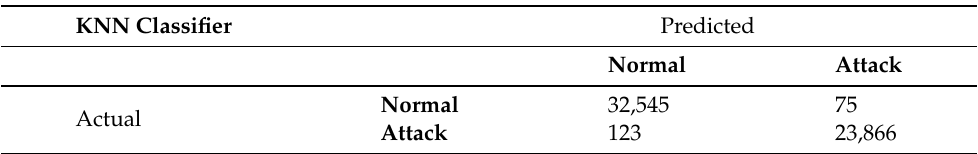
Table 4. Confusion matrix of K-Nearest Neighbors (KNN) classifier test for malicious and normal traffic detection over IoT healthcare dataset generated using IoT-Flock [16,24].